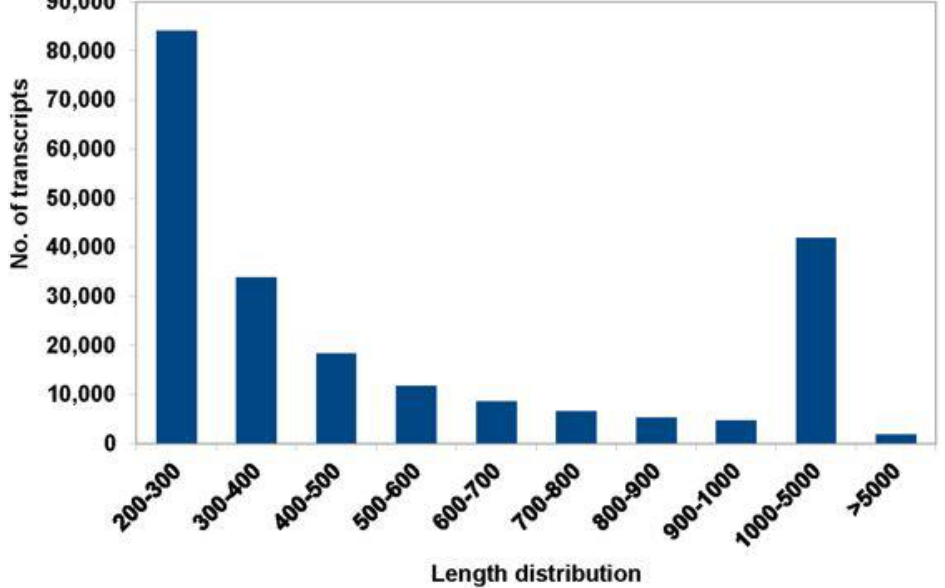
Figure 2. Length distribution of de novo assembled transcripts. Y-axis represents the no. of transcripts for the length distribution on the x-axis.